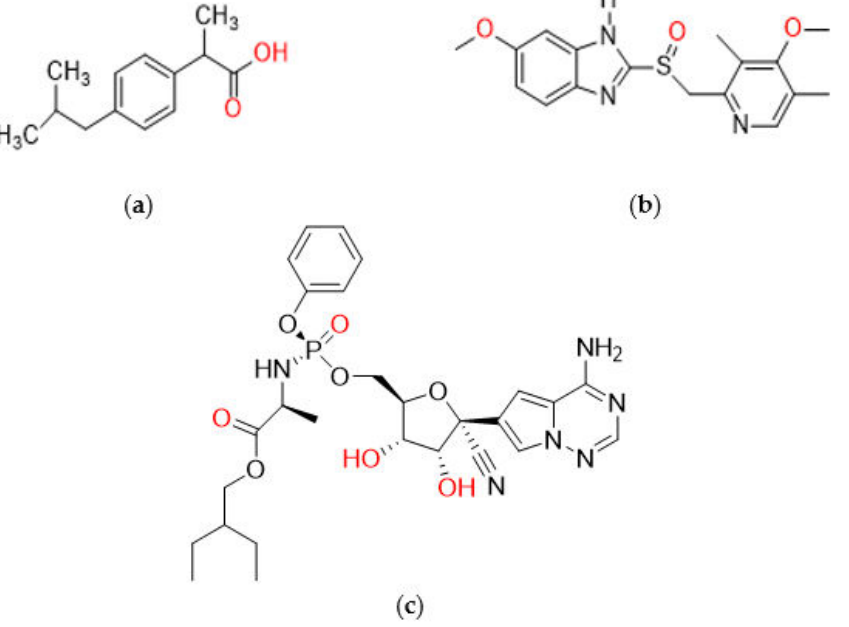
Figure 1. Chemical structures illustrating: ( a ) ibuprofen; ( b ) omeprazole; ( c )